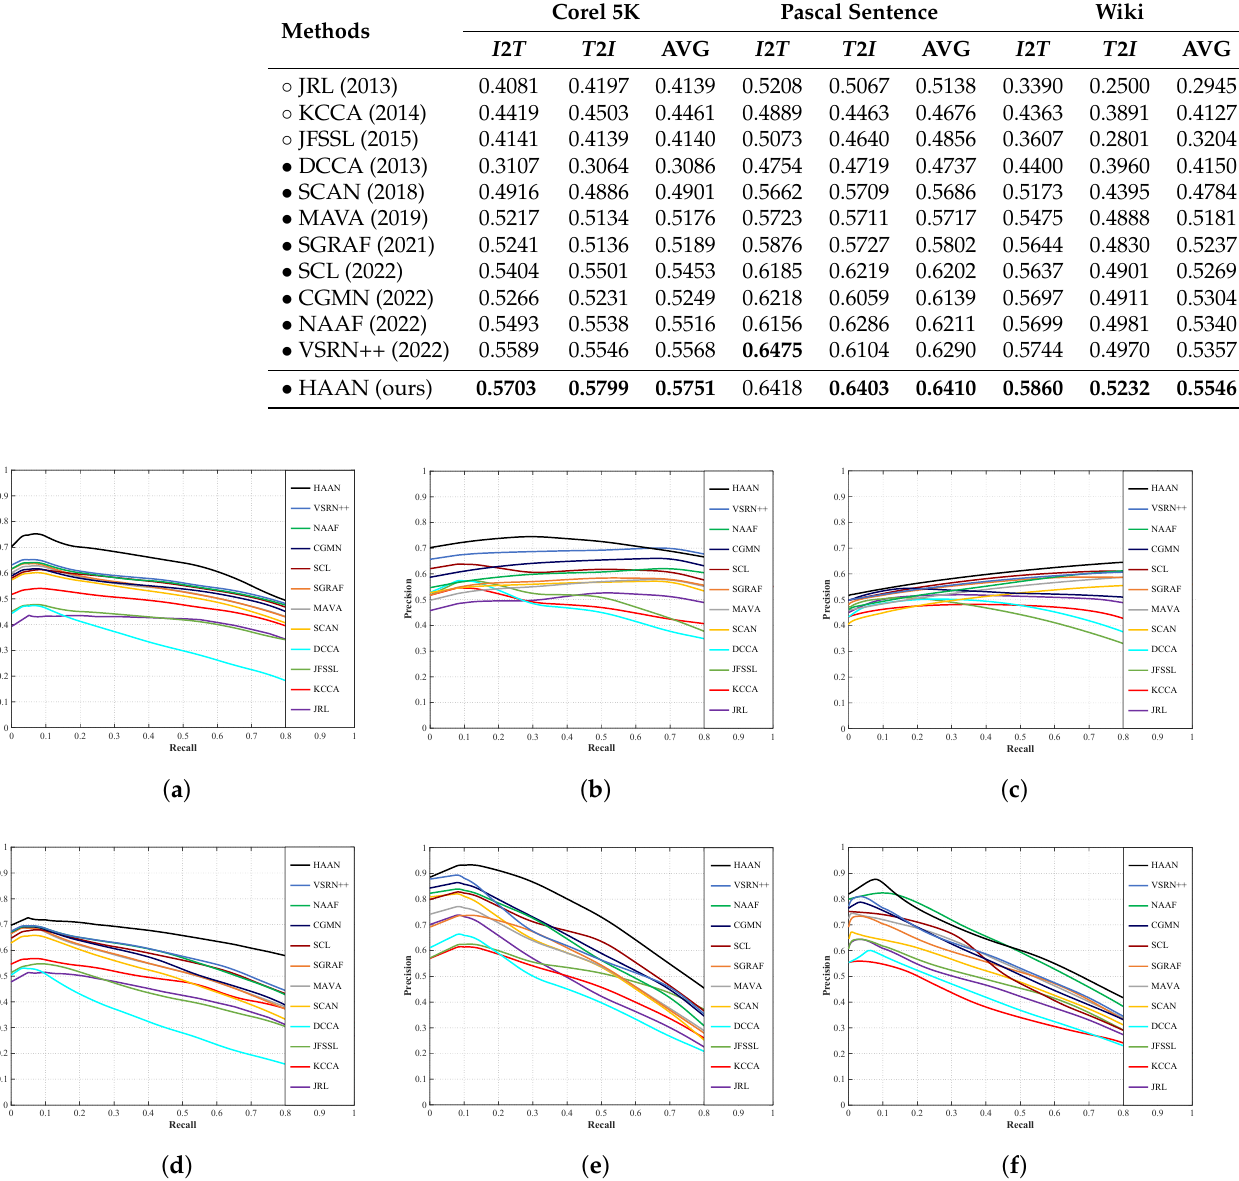
Table 3. The mAP scores of image-text retrieval for HAAN and other compared methods on all datasets.